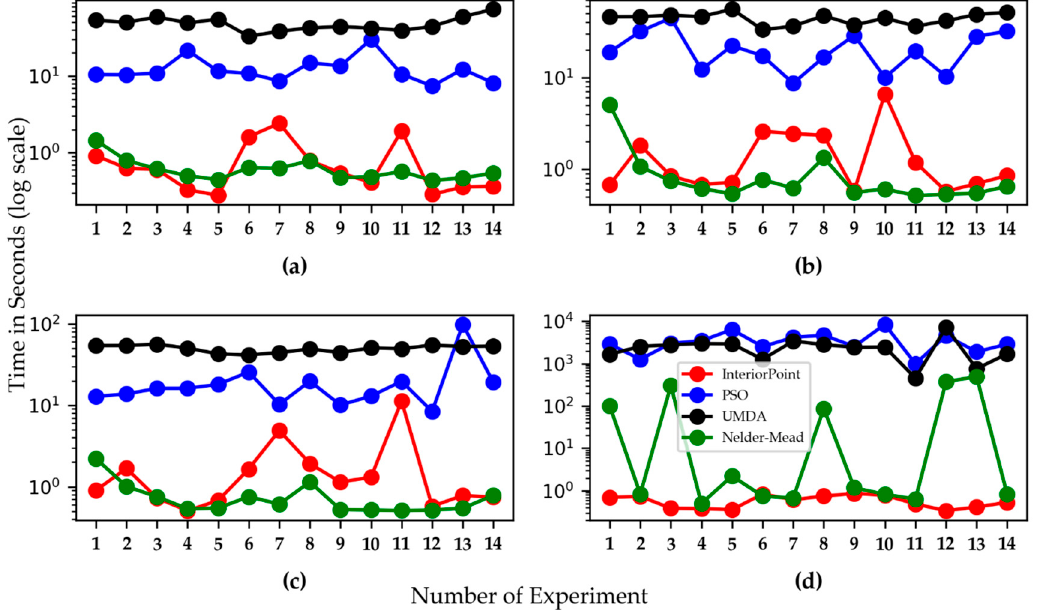
Figure 3. Comparison of the computation time required by each optimizer to find the best kinetic parameters. According to the difficulty of being optimized, the kinetic models are grouped into two categories, i.e., the first group with three models: ( a ) Michaelis–Menten, ( b ) non-competitive inhibition and ( c ) competitive inhibition, and the second group with ( d ) the Substrate Inhibition model.